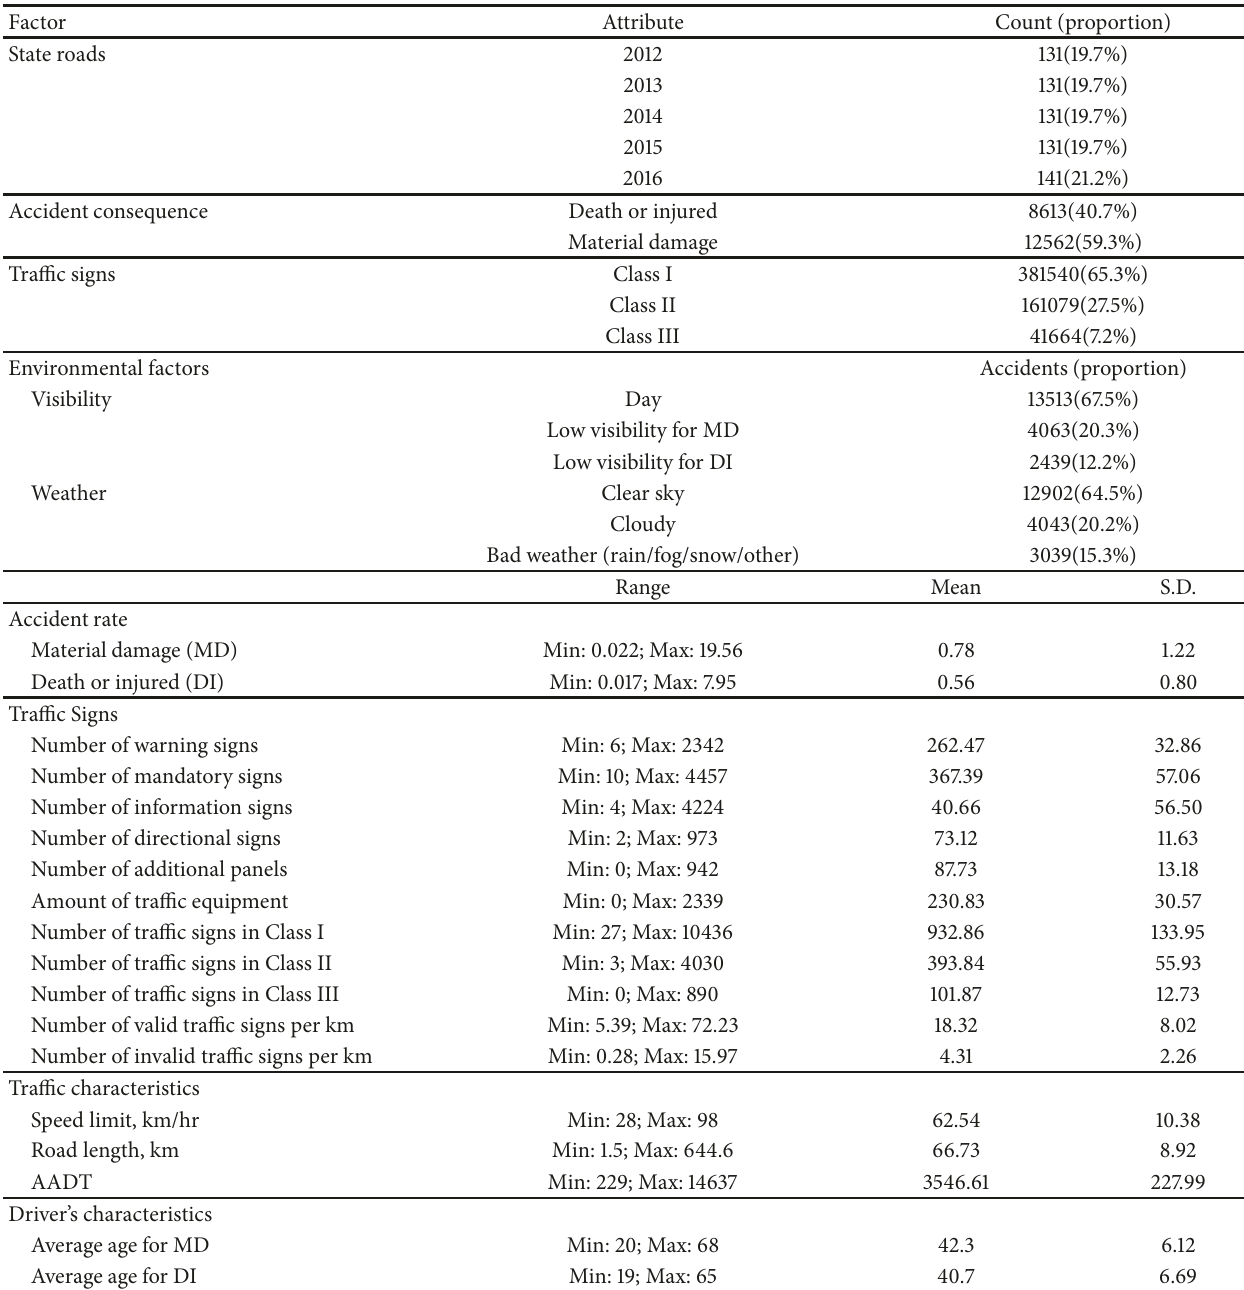
Table 1: Summary of the